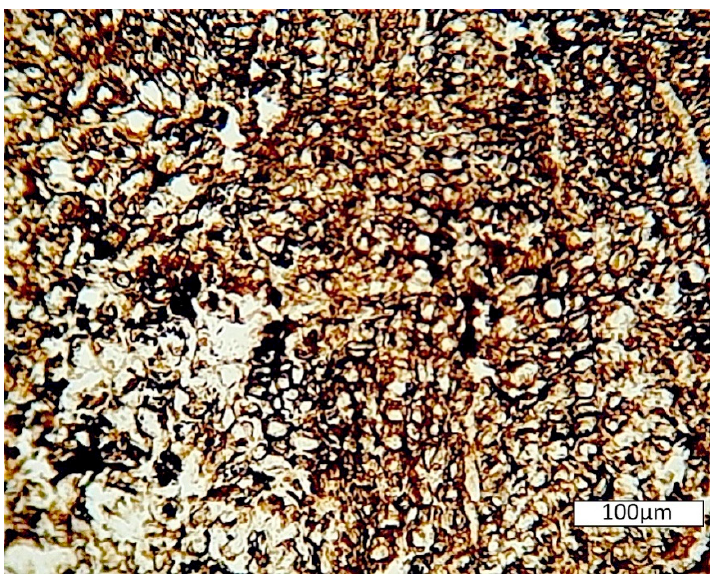
Figure 8. Partially decayed Lower Cretaceous conifer wood from Apple Bay.